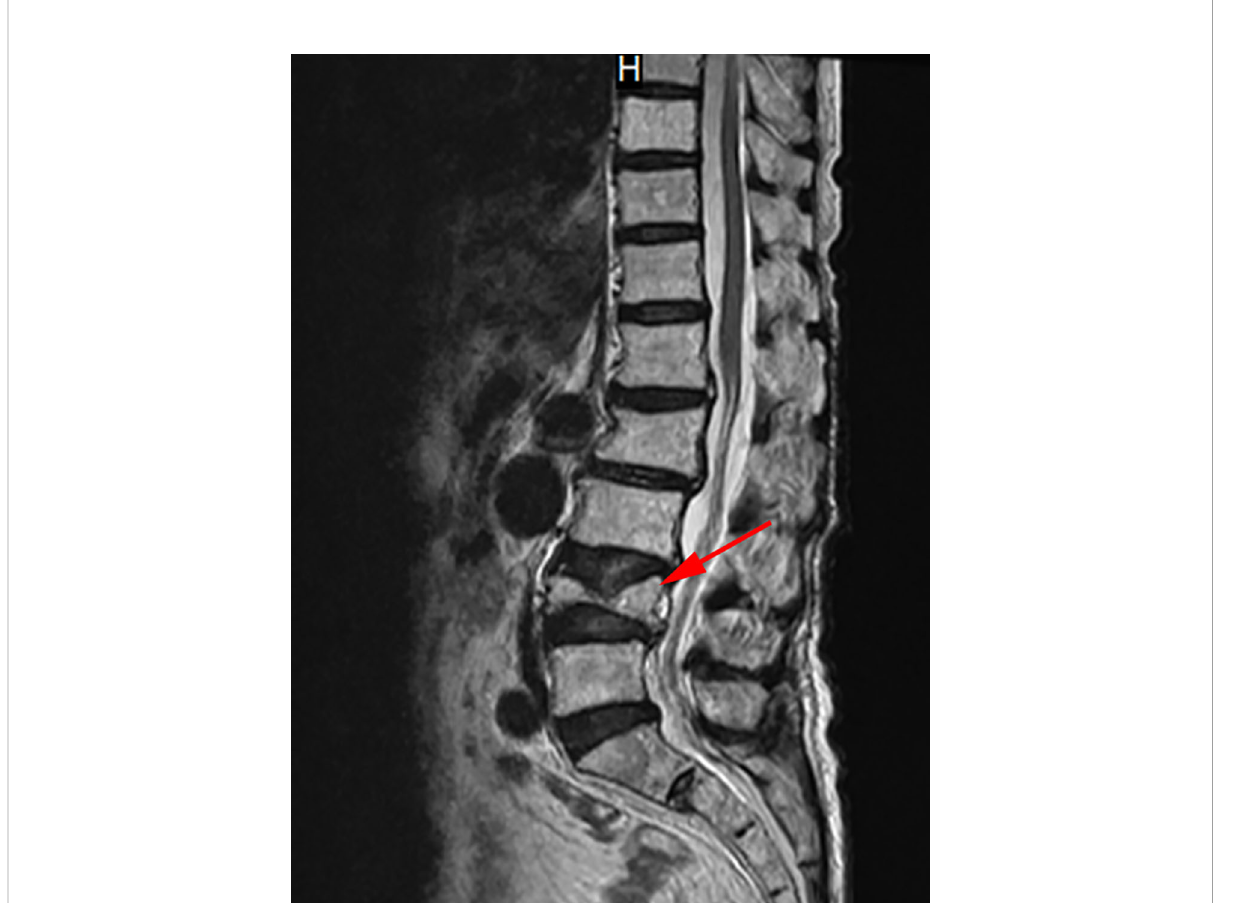
FIGURE 1 MRI of the lumbar vertebra. This image shows the MRI of the patient ’ s lumbar vertebra. The red arrow marks the 4th lumbar vertebra with a compression